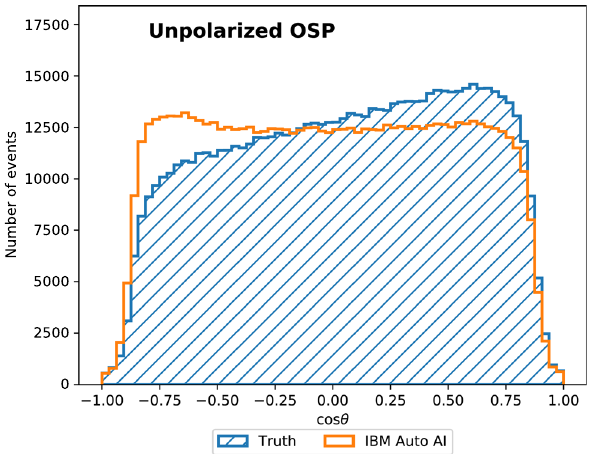
Fig. 11 Angular distribution in the W boson rest frame as a function of cos ϑ , obtained using the IBM auto AI tool as a binary classificator. Parton-level (truth) distributions are shown for comparison, using the generator-level (true) cos ϑ